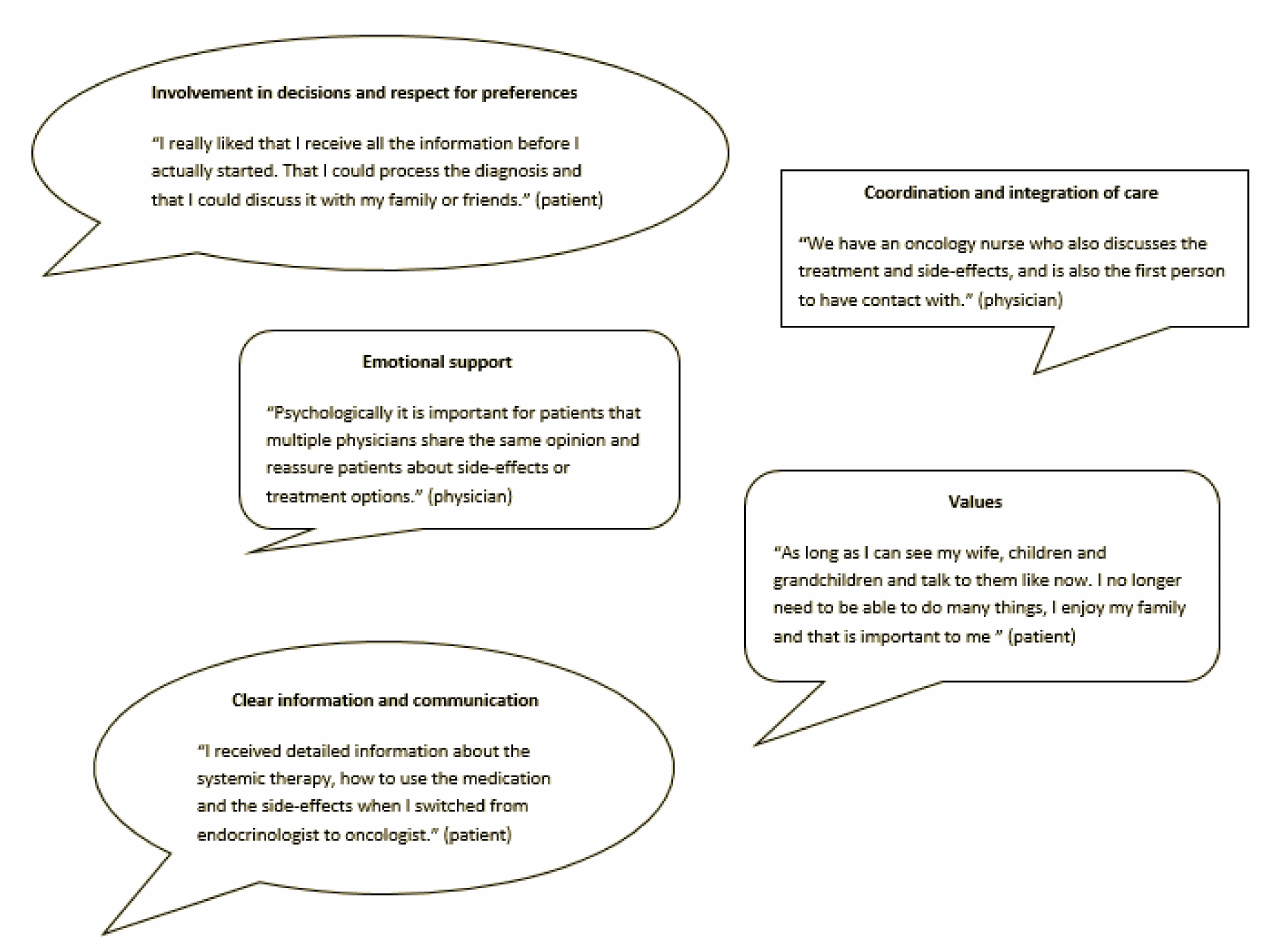
Figure 1. Quotes expressed by patients with DTC and by physicians treating patients with DTC for each Picker